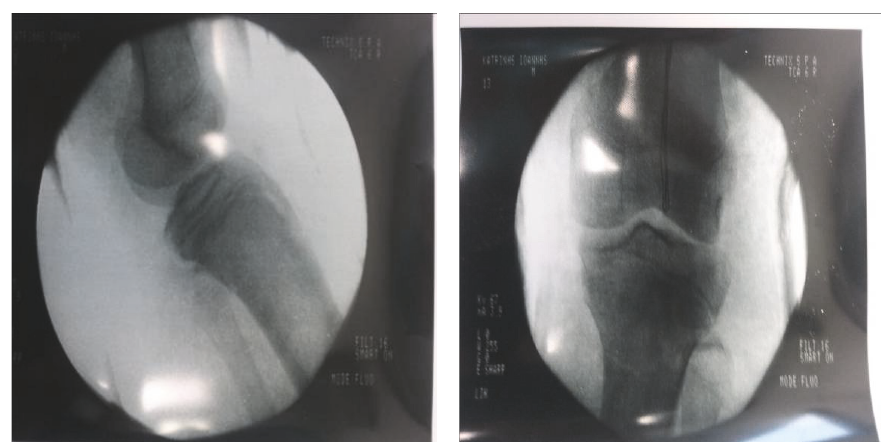
Figure 2: Fluoroscopic image showing successful closed reduction of the fracture.